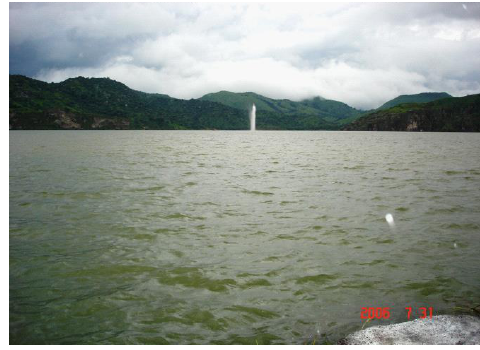
Figure 16. Lake Nyos degassing process (Source: fieldworks, July 2006).